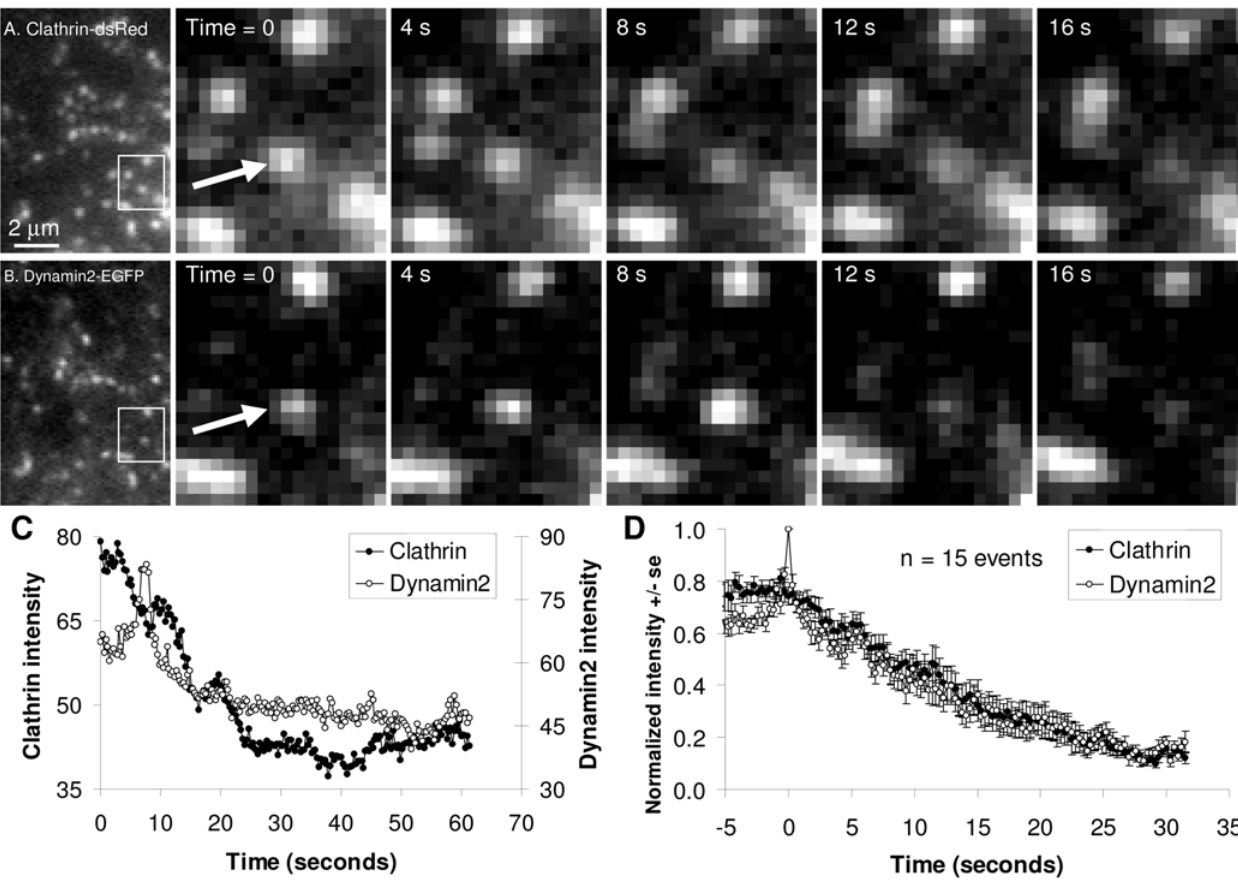
Figure 4. Increase in dynamin2 intensity at sites of clathrin-mediated endocytosis in PC12 cells. PC12 cells co-transfected with clathrin- dsRed (A) and dynamin2-EGFP (B) were imaged by live-cell TIR-FM. Frames with time-stamps represent magnifications of regions identified directly to the left. Quantification of the spot marker by the arrow (C) shows burst of dynamin2 fluorescence just prior to endocytosis. Additionally, clathrin fluorescence remains roughly constant prior to internalization. Quantification of 15 such events is shown is (D).